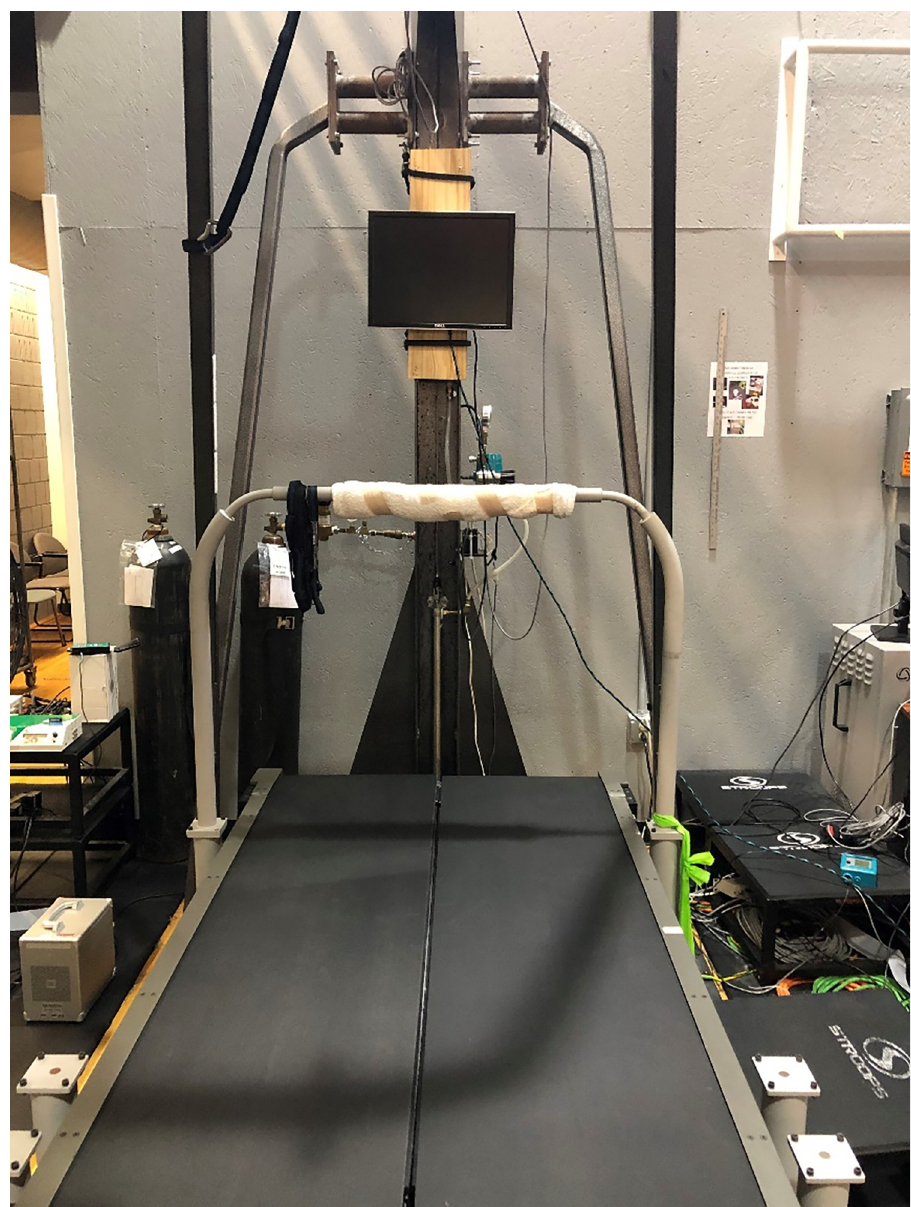
Fig 3. Treadmill display. The monitor mounted to the front of the treadmill that displayed the animations for real- time visual feedback. monitor, and a safety harness, shown in Fig 4. The RIP belts were consistently placed on the participant with the chest belt at the level of the xyphoid process and below the pectoral mus- cles, and the abdomen belt at the level of the navel, as previous RIP research has prescribed [37, 38]. A neoprene belt with hook and loop fabric covering (CoreX Therapy, Perfect Practice, Inc.) was placed at the level of the waist to house the additional equipment needed for RIP, which included a BioRadio and two interface cables (Great Lakes NeuroTechnologies, Cleve- land, OH). A Polar H7 heart rate monitor (Polar Electro Inc., Bethpage, NY) was placed on bare skin between the previously mentioned RIP belts. Each participant was fit with a custom-